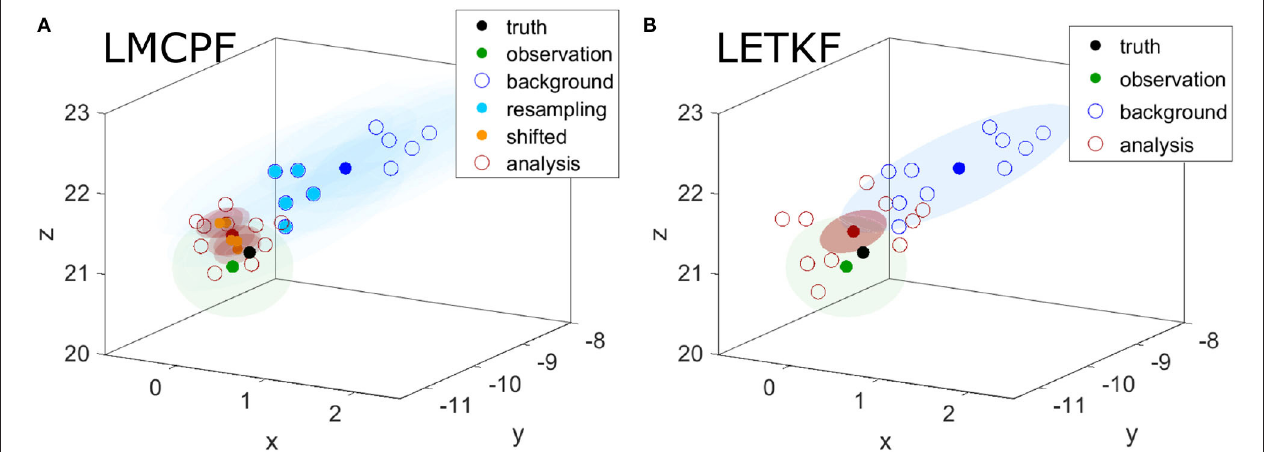
FIGURE 4 | The background ensemble (blue circles) is generated from a bimodal distribution and the observation (green point) is located near one of the modes. The dark blue point illustrates the background ensemble mean. In (A) , the assimilation step is performed with the LMCPF method and in (B) with the LETKF method. The light blue points in (A) illustrate the resampled particles and the orange points describe the shifted particles for κ LETKF are represented by the red circles and the red point illustrates the analysis ensemble mean. In the LMCPF method, these particles are randomly generated from Gaussian distributions with the shifted particles as expectation vectors. The shaded areas denote Gaussian ellipsoids with respect to the corresponding covariance matrices.